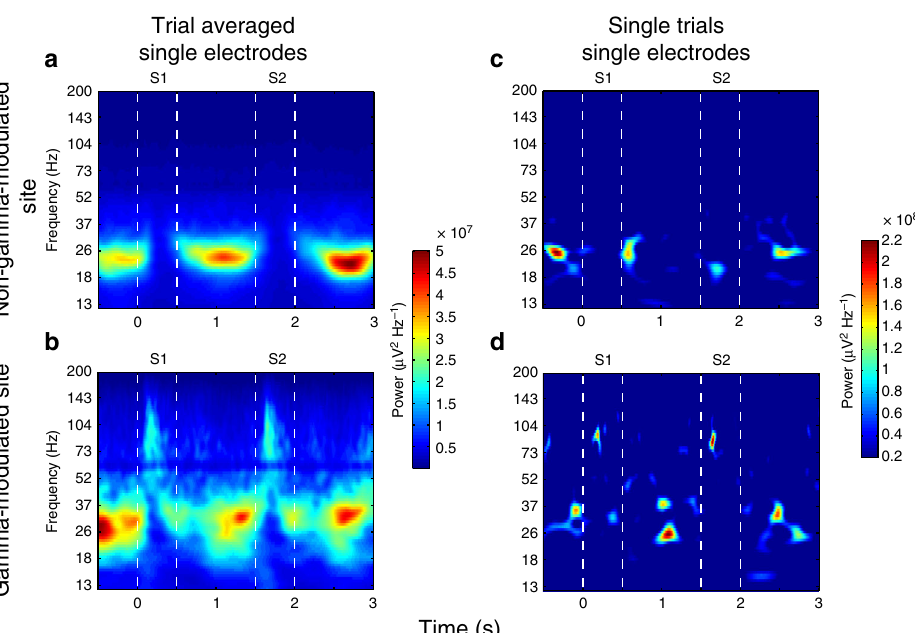
Fig. 2 Trial-averaged and single-trial spectrograms. Example of trial-averaged spectrograms of a non-gamma-modulated a and a gamma-modulated b recording site. Displayed are the two sample object presentations, S1 and S2, and the following delays. Single-trial examples originating from the same two recording sites are shown in c (non-gamma-modulated) and d (gamma-modulated). Spectrograms were normalized by